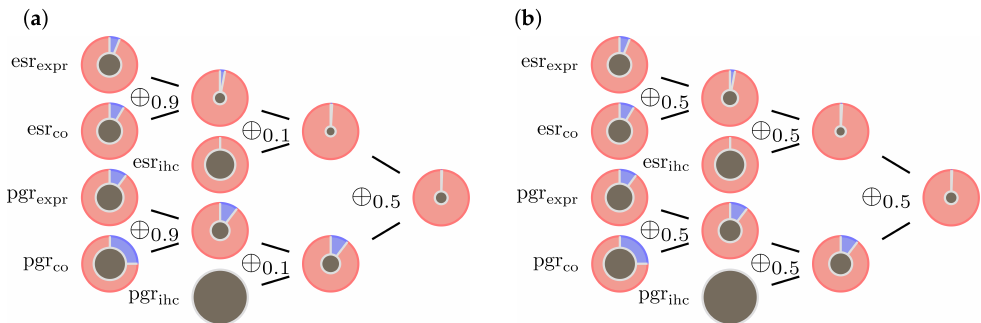
Figure 6. Consistent data inducing reliable outcome: ( a ) model (9) illustrated by a sample with very clear outcome (sample id = 1980). ( b ) When evidence is highly consistent, the parameter λ has practically no influence on the